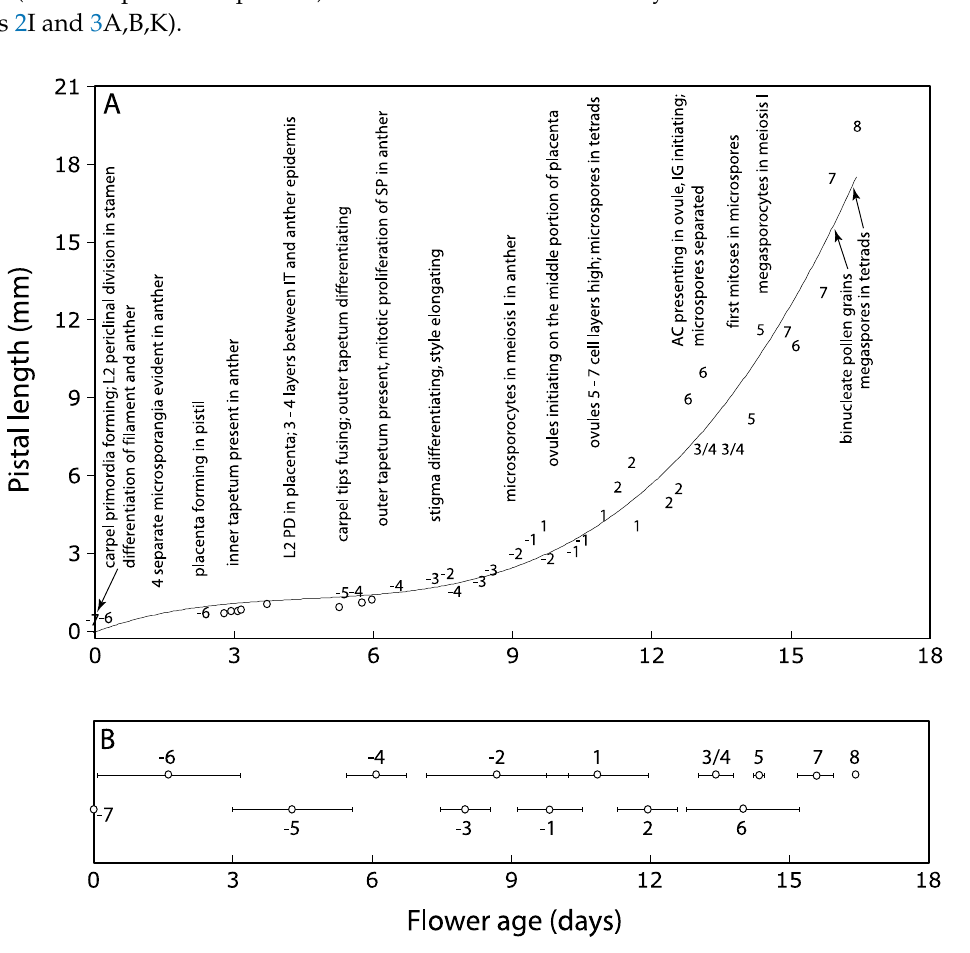
Figure 11. Tobacco pistil and stamen development over time. Plotted values (–7 through 8) are the developmental stages, as previously described by Koltunow et al. (1990). Flower ages are estimated by the PI approach. ( A ) Flowers are staged by the major developmental events and morphological characteristics in anther and pistil [30]. The correlational relationships between the pistil length and time was calculated as Y = 0.0091X 3 − 0.126X 2 + 0.6697X − 0.1001, where Y was the pistil length and X was the time (R 2 = 0.9449). PD, periclinal division; SP, sporogenous cell; AC, archesporial cell; IG, integument; 3 / 4, Stages 3 or 4. Eight flowers indicated by the open circles are categorized as Stage –5 based on the characteristics “inner tapetum present, and no outer tapetum present” in the anthers. However, these flowers are also categorized into Stage –6 based on the morphological characteristics of “carpels not fused” in pistil. ( B ) Summary of the average ages (with standard deviations presented horizontally) of tobacco floral developmental stages. The eight flowers presented by the open circles in ( A ) are included in Stage –5 in the calculation of average